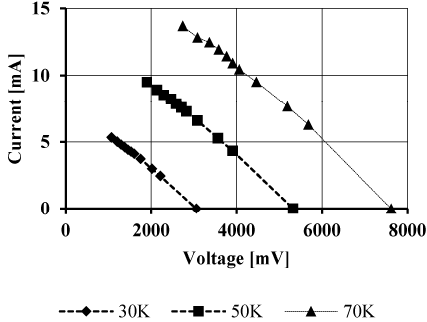
Figure 6. V - I -characteristic of a thin-film TEG at different gradients and a constant cold side temperature (0 °C).